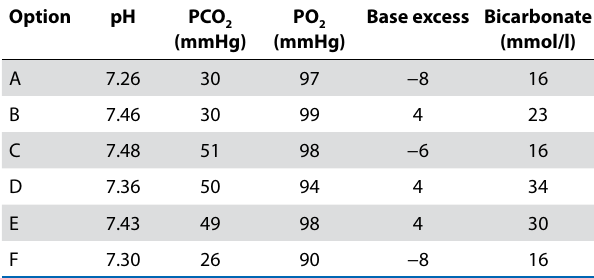
Table 1: Blood gas result options